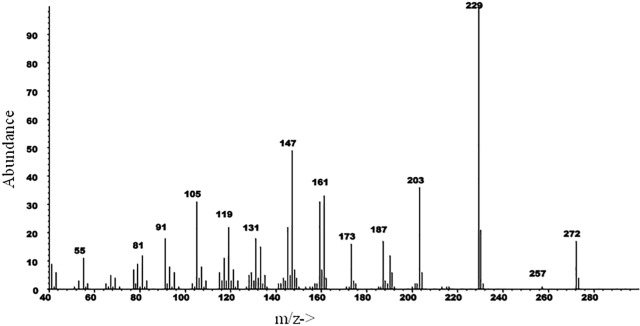
EI mass spectrum of the major compound in VOC extracts from B. oleracea var. botrytis.